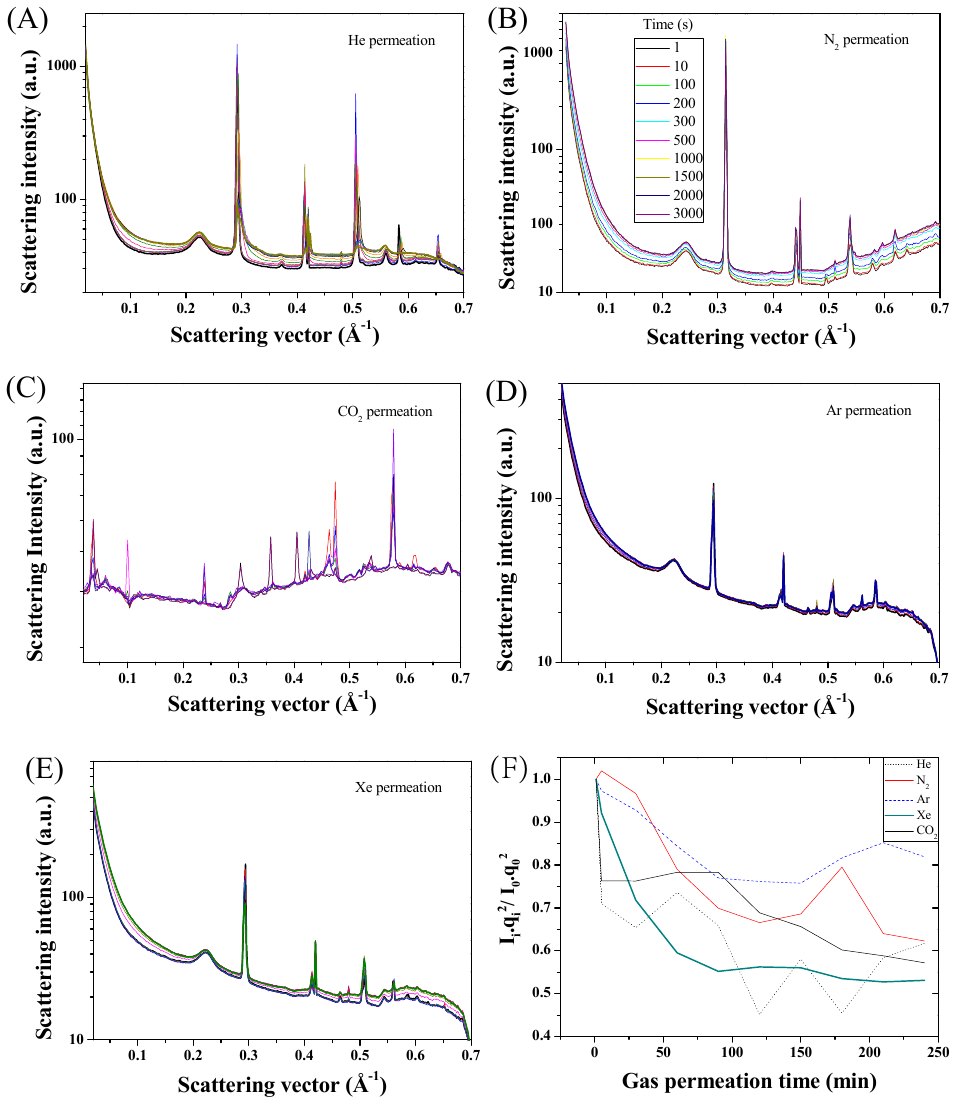
Figure 3. ( A – E ) Example of integrated scattering data shifts for the ZiF-8@BP membranes for the series of gas tested (A—He, B—N 2 , C—CO 2 , D—Ar, and E—Xe). ( F ) Correlation between the normalized Iq 2 /Iq 2 and the permeation of the different gas for the series of membranes at q = 0.52 Å − 1 corresponding to the (110) of the ZiF-8 lattice. Part of the intensity changes may, however, be attributed to the background change over time, due to the increase of pressure on the permeate side, and clear peak shifts occurred at various scattering vectors corresponding to the critical dimensions of the ZiF-8 crystal units. The color schemes are the same for all the shown data taken at fixed permeation times.